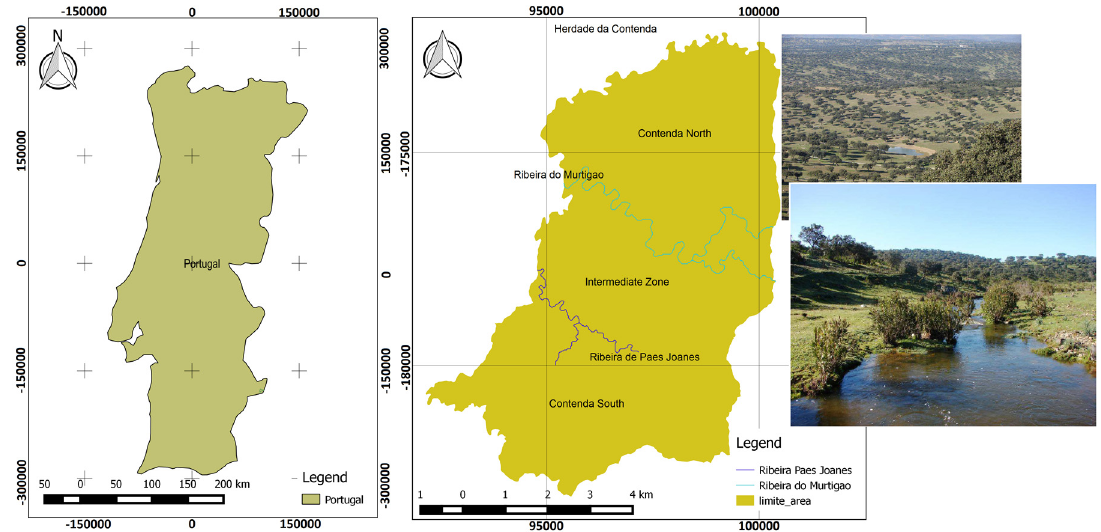
Figure 1. Study case: Herdade da Contenda (HC) region, Alentejo Portugal.